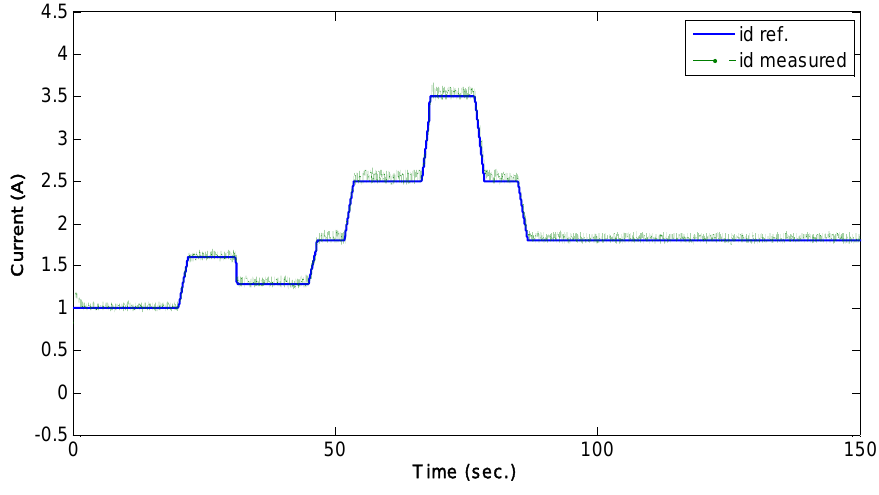
Figure 14. Response of the controlled rotor d -current.